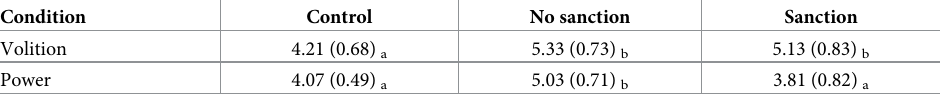
Note . Means within a row with a different subscript differ at p <